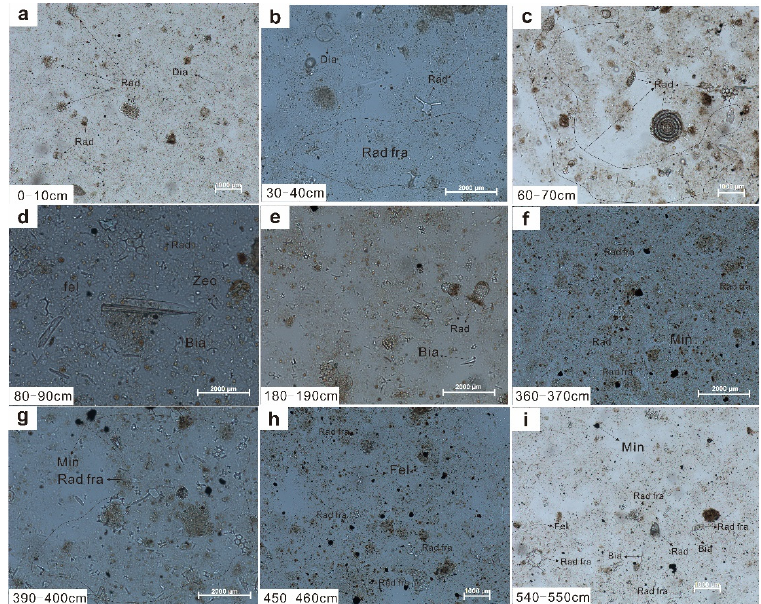
Figure 3. The optical photomicrographs of samples from the core. Abbreviations: Rad, Radiolaria; Dia, diatom; Bia, bioapatite fossil; Zeo, zeolite; Min, micronodule; Fel, feldspar. ( a – i ) represent the composition of substances under the microscope at different depths of GC04 respectively.